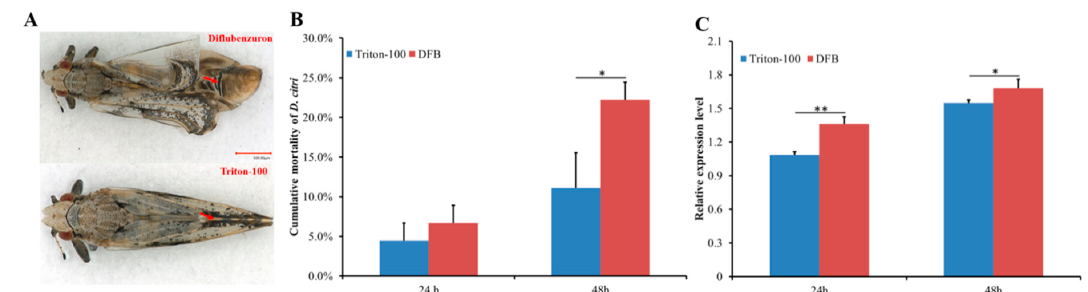
Figure 4. Effect of diflubenzuron (DFB) on Diaphorina citri morphology, mortality rate, and DcCHS expression levels. ( A ) Phenotypes of D. citri at 24 h of DFB treatment and Triton-100. ( B ) Cumulative mortality of D. citri following feeding with DFB and Triton-100 (Control). ( C ) Relative expression of DcCHS in D. citri feeding with DFB and Triton-100 (Control). The mean expression level represented for three biological replicates. Relative expression levels were calculated using the 2 −∆∆ C t method. Statistical analysis was performed using SPSS software. The significant differences are indicated by * ( P < 0.05) or ** ( P < 0.01).